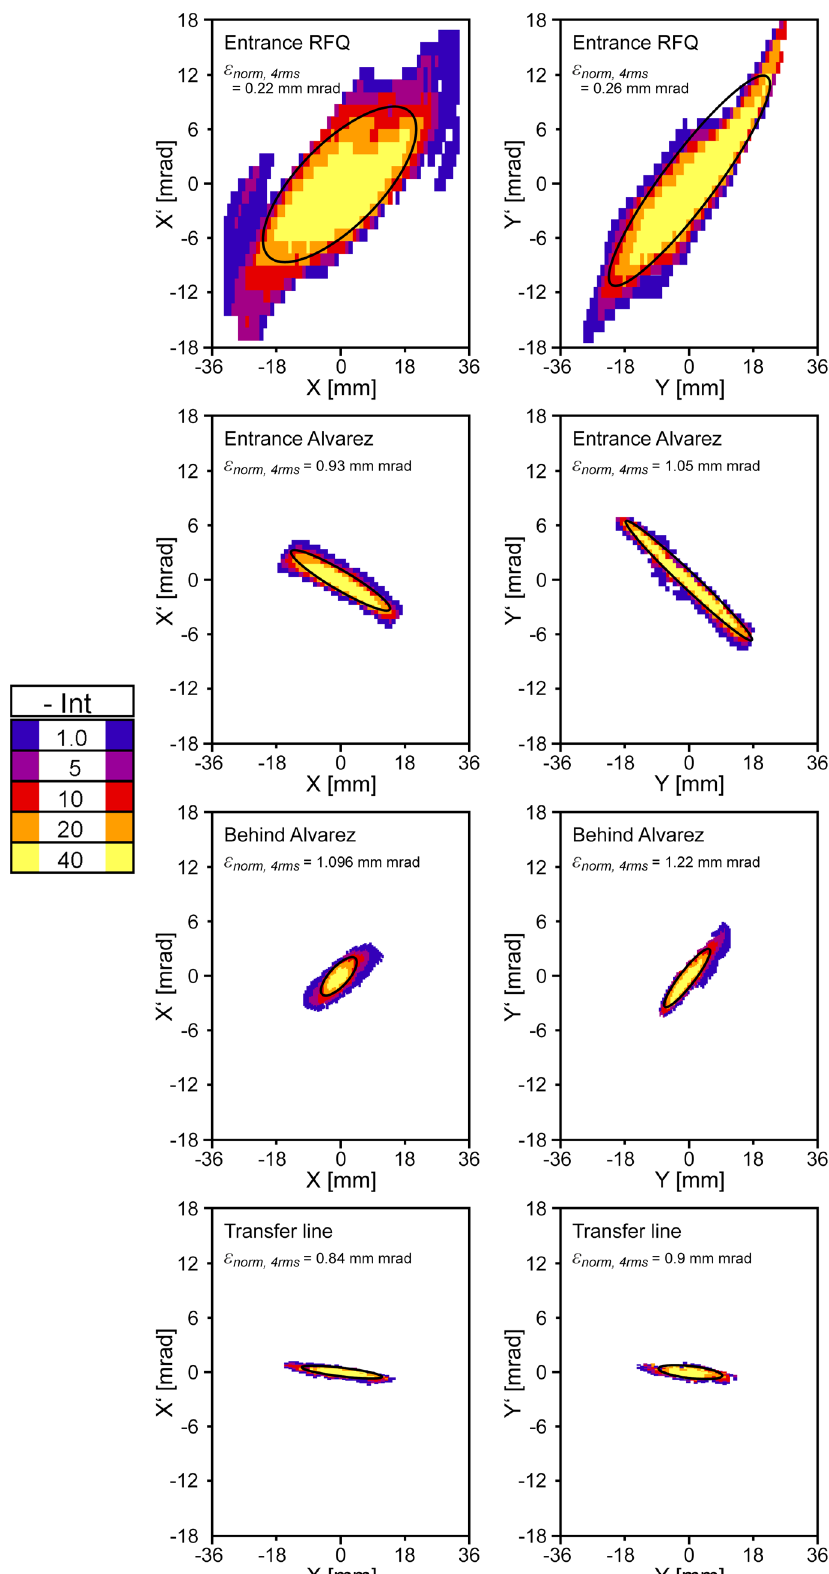
FIG. 10. Measured high current proton beam emittance